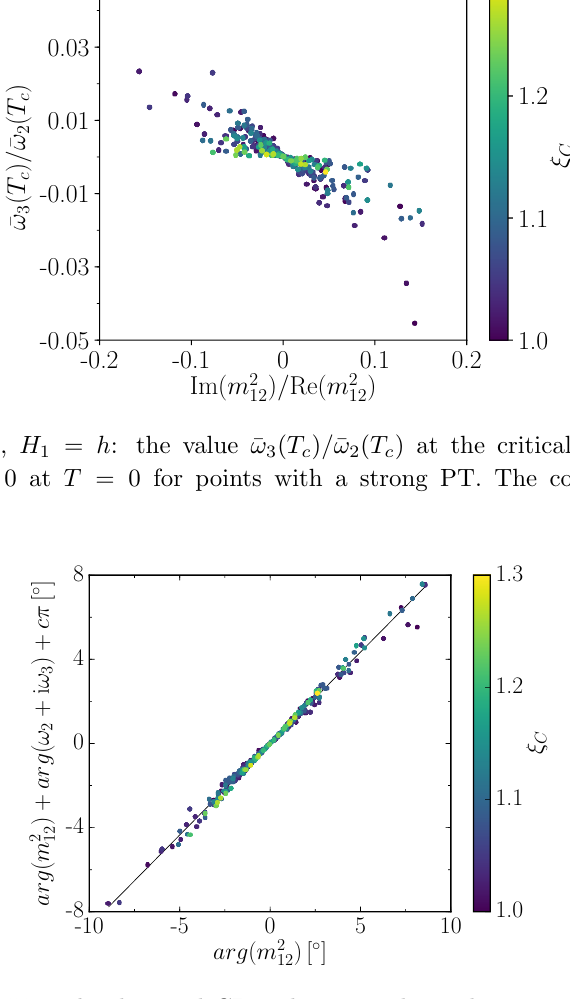
1 ; 0 ; 1 , the angle is ensured to lie in the 2 f(cid:0) g